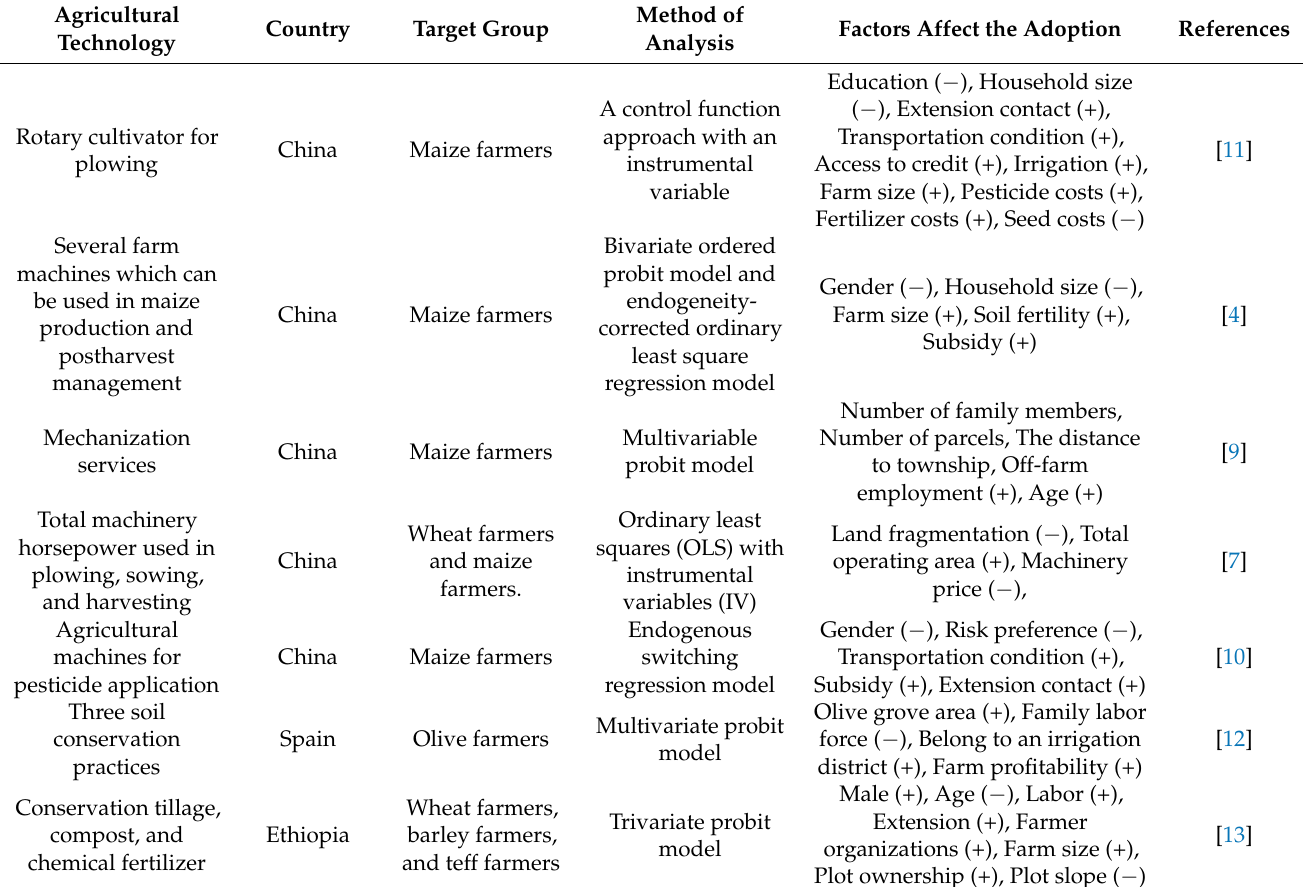
Table 1. The research of agricultural technology adoption: a